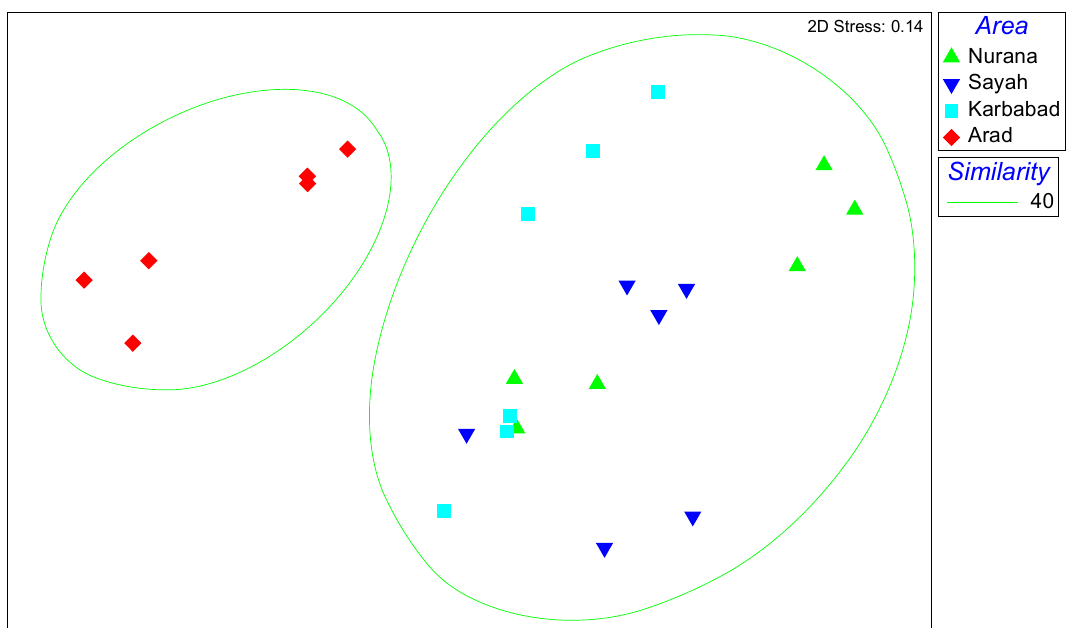
Figure 6. MDS of macrobenthic invertebrates in the study areas in the summer and winter revealed two distinct clusters for Arad Bay and the remaining study areas. Cluster analysis was imposed on the MDS, showing a 40% similarity.